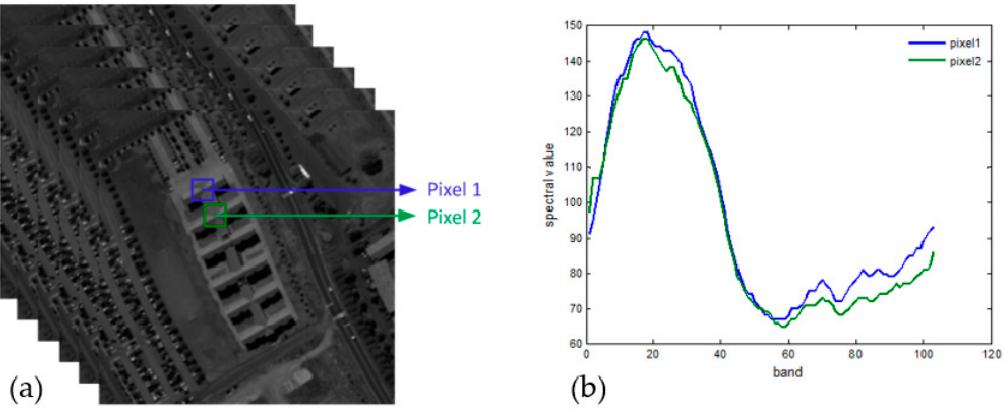
Figure 2. Similar pixels in a sample hyperspectral image: ( a ) A three-dimensional HSI; and ( b ) Reflected spectral curve at the corresponding pixels of each band in the HSI.